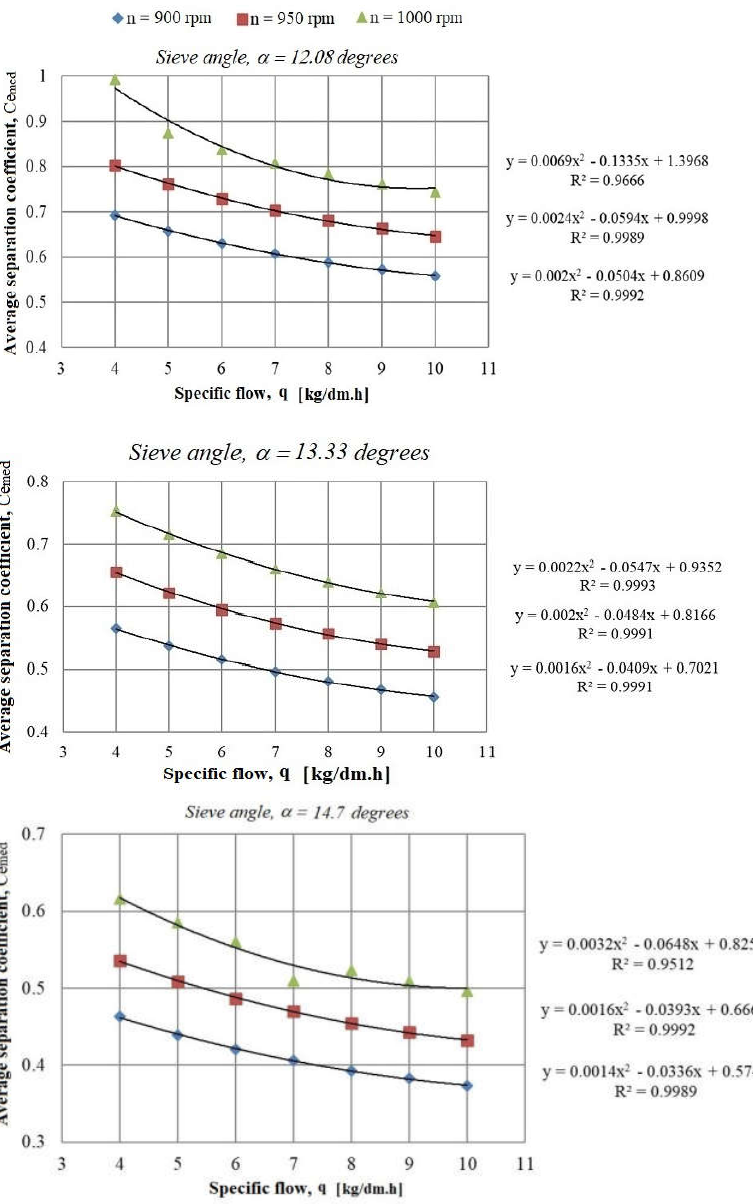
Figure 5. Variation in the separation coefficient for nettle depending on the specific flow for the three angles of sieve inclination. angles of sieve